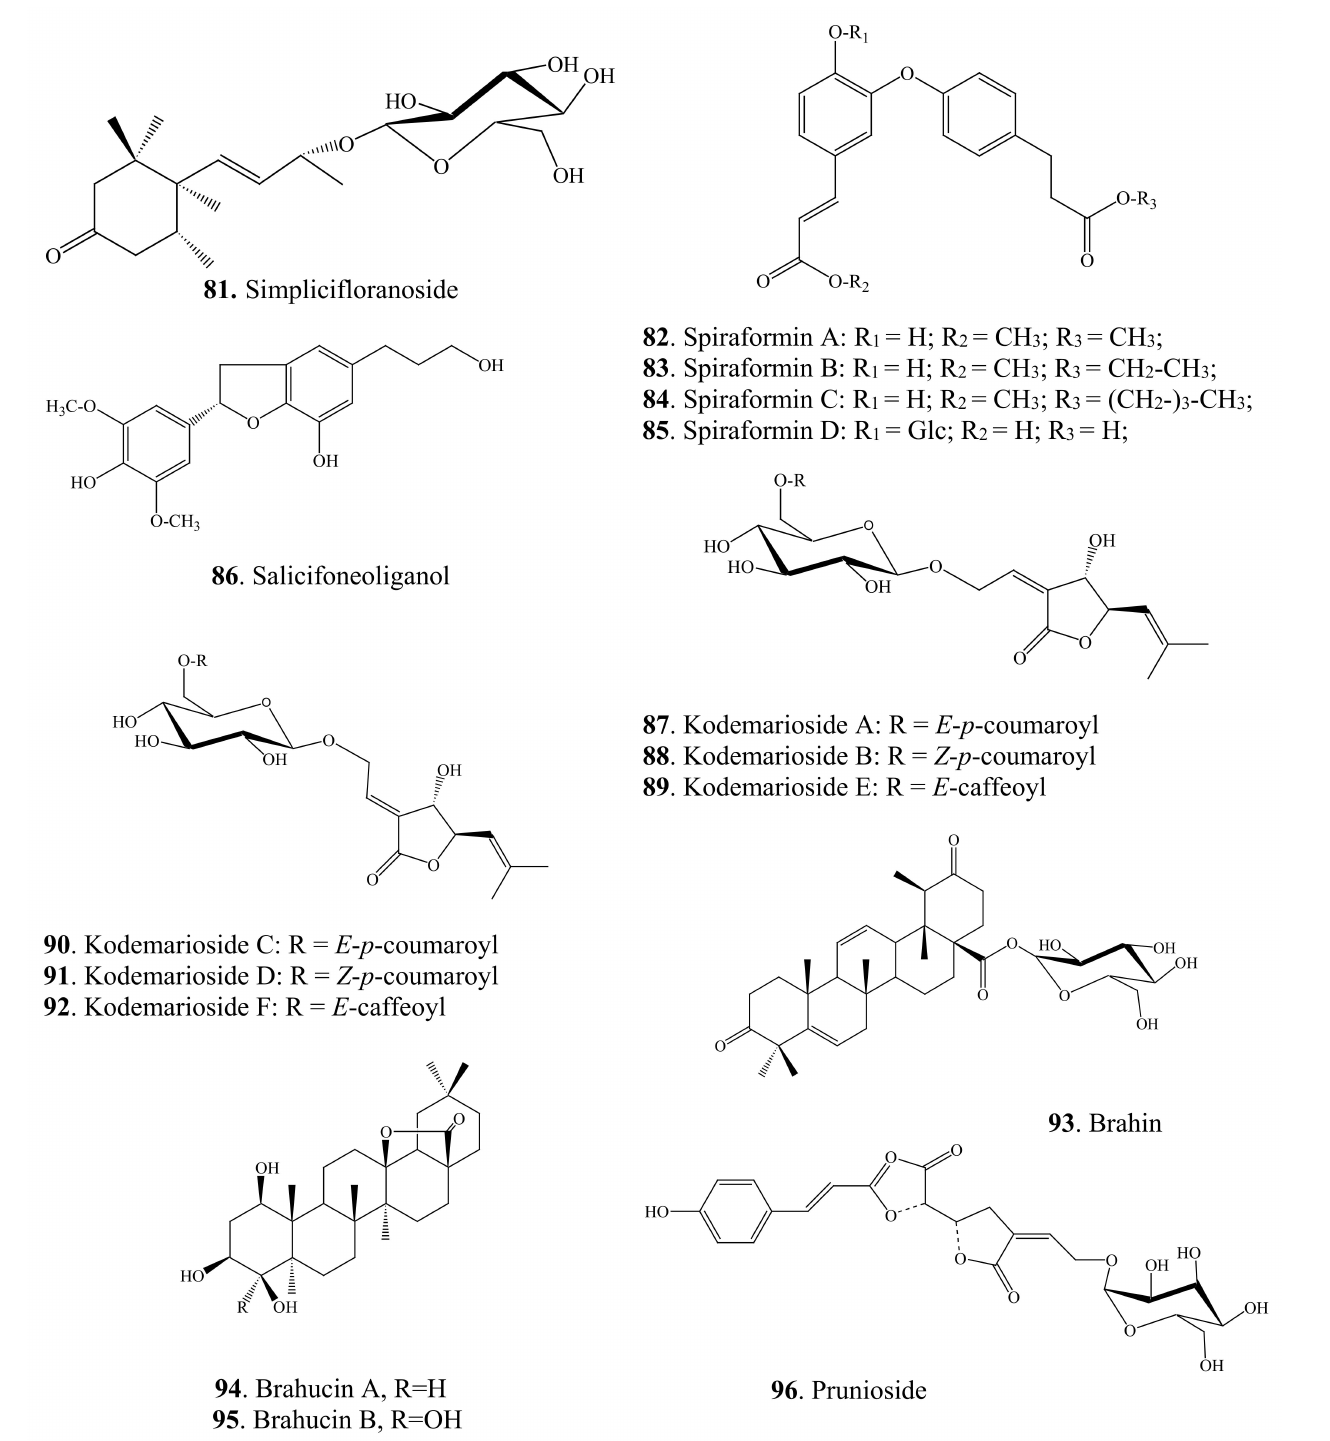
Figure 2. Other new secondary metabolites found in